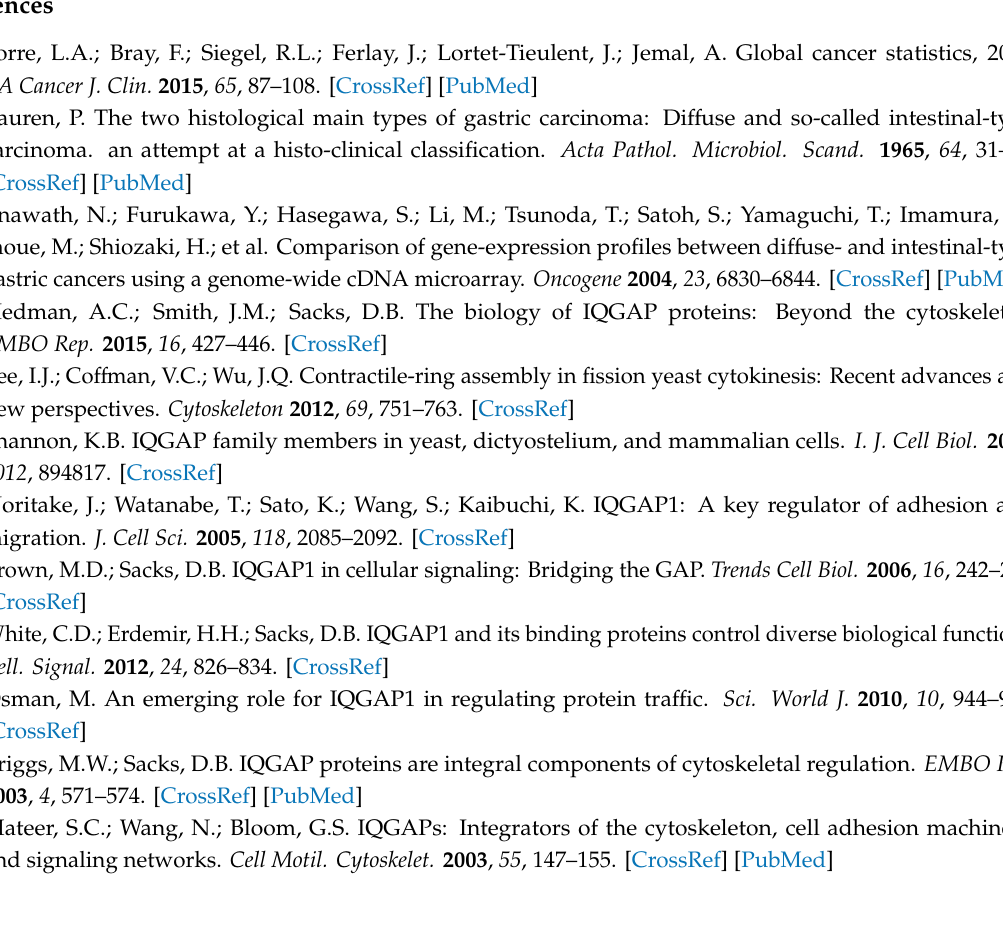
Figure S1: The knock-down e ff ect of IQGAP3 -siRNAs used in this study, Figure S2: Expression of IQGAP3 in di ff use and intestinal subtypes of gastric cancer, Figure S3: Frequencies and types of genetic alteration identified in IQGAP3 , Figure S4: Expression of IQGAP3 in patients with di ff erent clinical characteristics analyzed by UALCAN (http: // ualcan.path.uab.edu / ), Figure S5: Kaplan-Meier plots of gastric cancer patients using microarray and RNA-Seq data from TCGA database by KMplotter, Figure S6: Overall survival of Asian patients in UCSC Xena (https: // xena.ucsc.edu / ), Figure S7: Original Western blots shown in Figure 4, Figure S8: Representative images of original Western blots shown in Figure 6, Table S1: Up-regulation of IQGAP3 protein expression in gastric cancers based on tissue microarray analysis, Table S2: Clinicopathological correlation of IQGAP3 protein expression with invasive phenotypes of gastric cancers based on tissue microarray analysis, Video S1: Subcellular localization of IQGAP3 in cells undergoing filopodia and / or lamellipodia formation, Video S2: IQGAP3 accumulation at